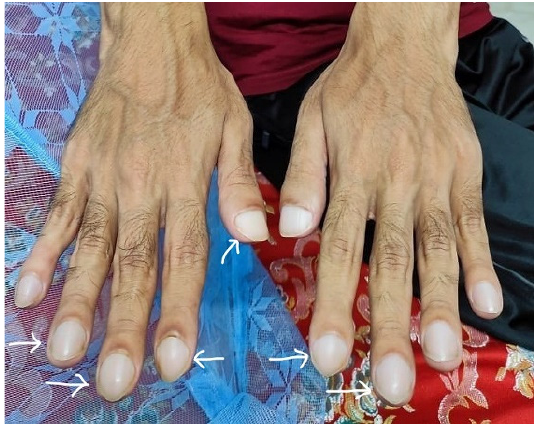
Figure 2. Clubbing of the fingers, marked with arrows.